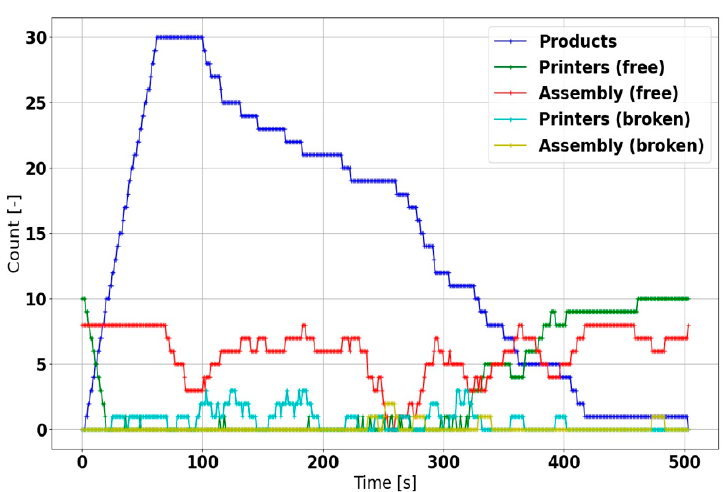
Figure 17. The discrete event simulation scenario with failure injection activated.